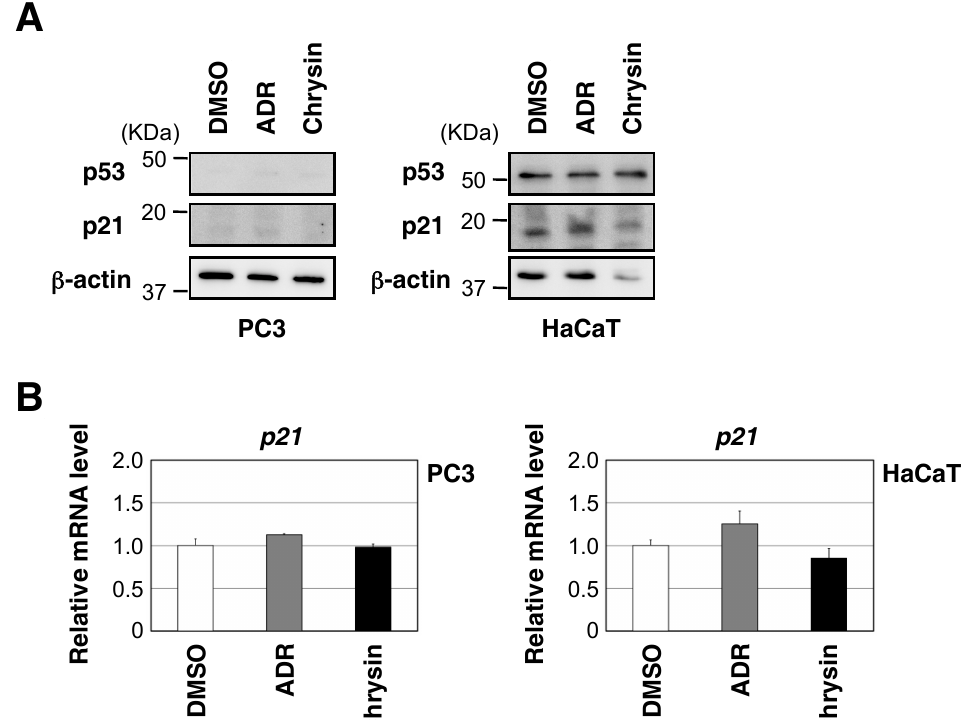
Figure 3. Chrysin did not increase p21 mRNA or p21 protein levels in p53-null and p53-mutant cells. ( A ) PC3 cells and HaCaT cells were treated with ADR (0.3 μ M) or chrysin (40 μ M) for 8 h. Cell lysates were immunoblotted with the indicated antibodies. ( B ) PC3 cells and HaCaT cells were treated with ADR (0.3 μ M) or chrysin (40 μ M) for 8 h. The expression of each gene was assessed by qPCR.